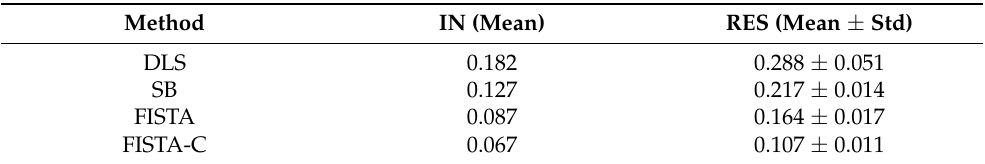
Figure 4. Reconstruction results of a single lesion target at various locations in the 3D head model under noise-free conditions. ( a ) Simulation model and imaging results of DLS, SB, FISTA, and FISTA- C. ( b ) Image noise (IN) analysis for imaging results of the four algorithms. ( c ) Resolution of imaging results of the four algorithms. Table 2. Image noise and resolution analysis for imaging results of the four algorithms for a single lesion target at various locations in the 3D head model under noise-free